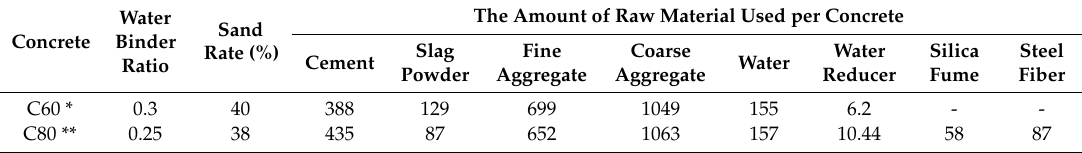
Table A4. Benchmark mixture proportion of C60 and C80 high-performance concrete.